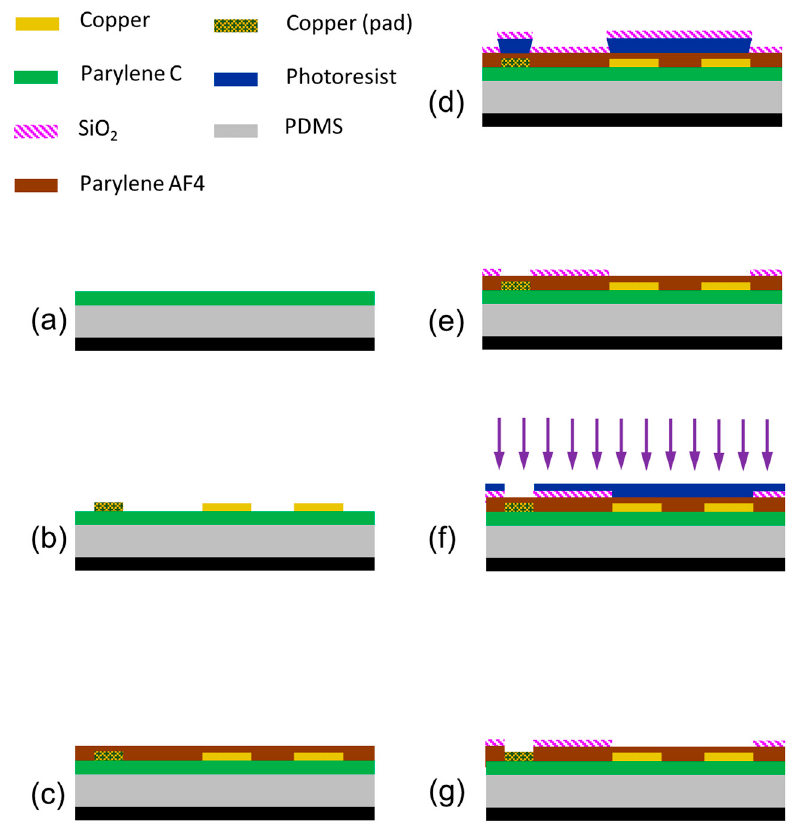
Figure 2. Microfabrication process of a flexible electrowetting-based tunable lens array. ( a ) 250 µ m of PDMS is spin coated onto a carrier wafer. After PDMS is cured, a 2- µ m layer of Parylene C is deposited as an adhesive layer. ( b ) 275 nm of copper is deposited via magnetron sputtering and then patterned and wet-etched into areal density modulated array electrodes along with traces and pads. ( c ) 800 nm of Parylene AF4 is deposited over the whole wafer to act as a pinhole free dielectric layer. ( d ) A lift-o ff type photoresist is patterned to cover contact pads and define the hydrophobic region immediately over the areal-density-modulated electrodes for each lens, then 100 nm of SiO 2 is deposited via radio-frequency (RF) sputtering. ( e ) Lift-o ff of SiO 2 was preformed via ultrasonic agitation in acetone. ( f ) Positive photoresist is patterned to protect all of wafer except areas over contact pads. A 200-W oxygen plasma is applied to etch Parylene AF4 down to copper contact pads to allow electrical contact to each device in the array. ( g ) Photoresist is stripped and a final cleaning of the wafer is completed.